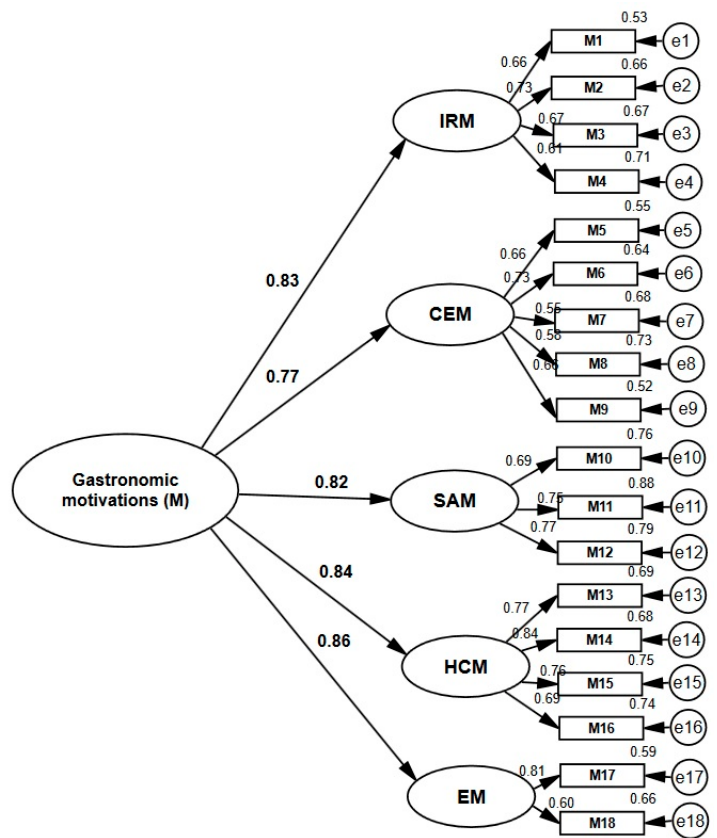
Figure 3. Second order confirmatory factorial analysis. IRM: Interpersonal relationship motivations.